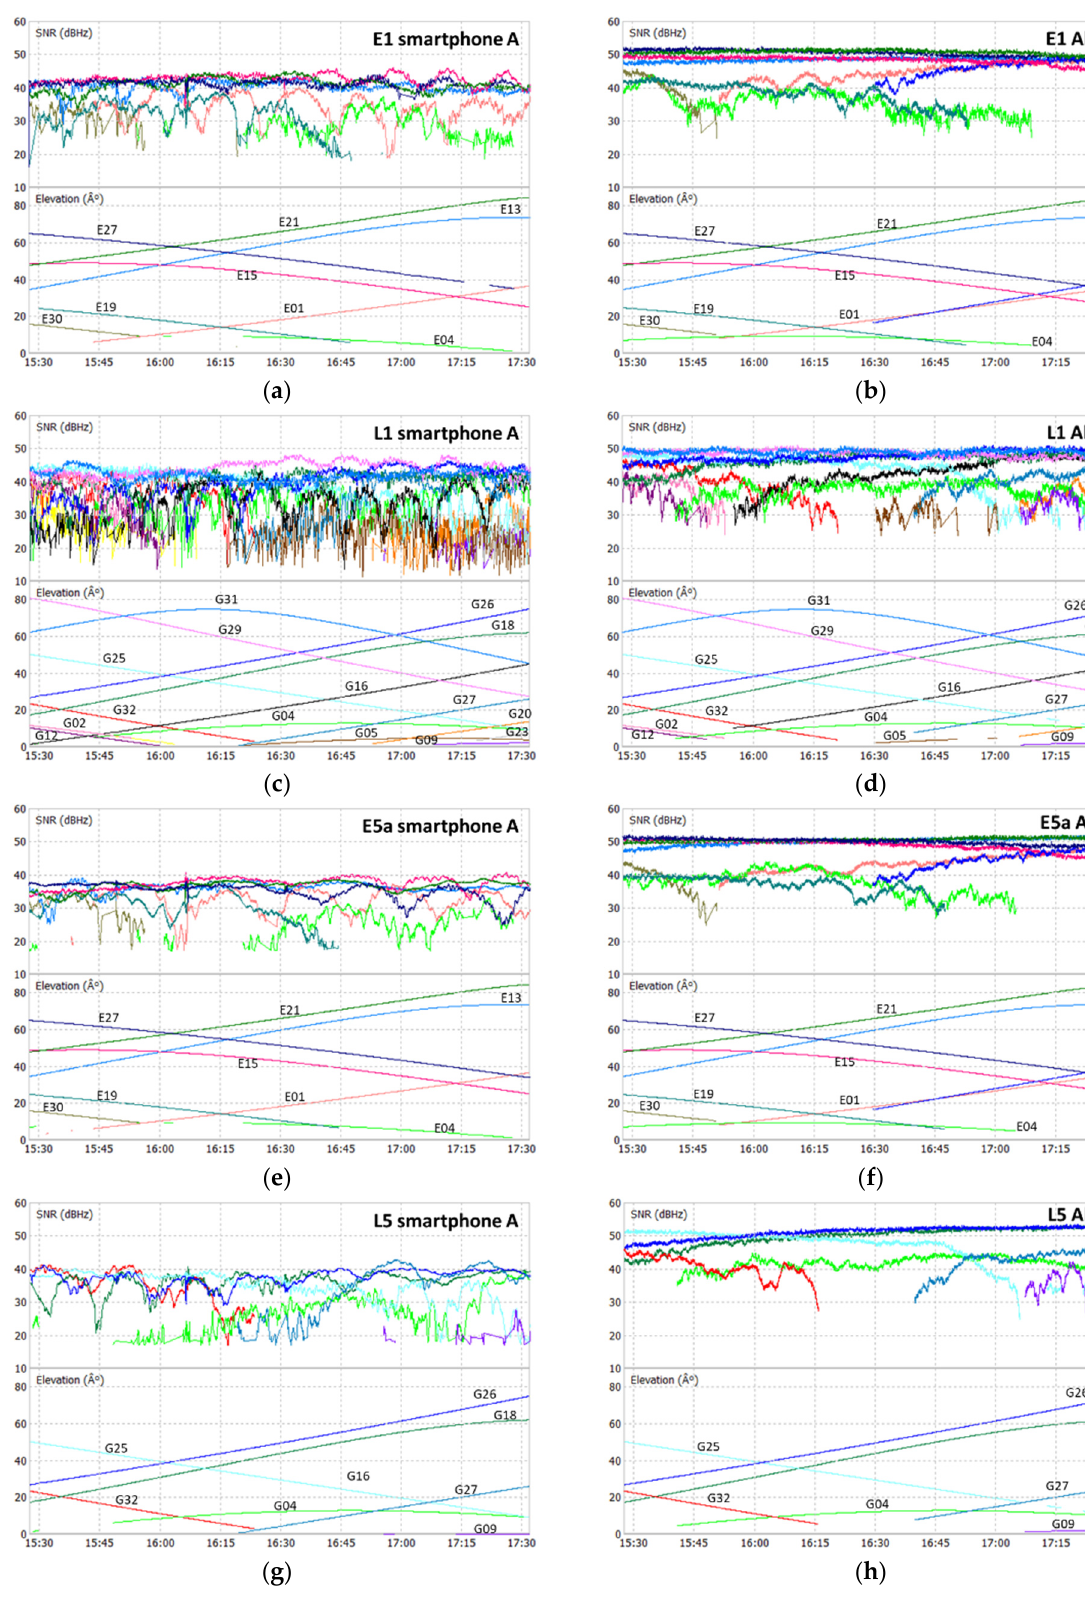
Figure 8. Test 2 SNR: E1 smartphone ( a ) and receiver ( b ); L1 smartphone ( c ) and receiver ( d ); E5a smartphone ( e ) and receiver ( f ); L5 smartphone ( g ) and receiver ( h ).